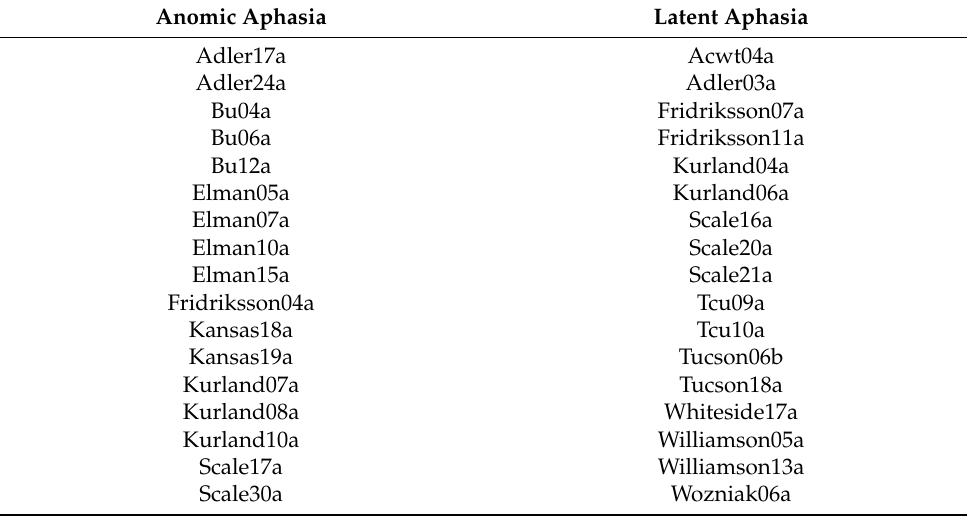
Table A1. AphasiaBank participant